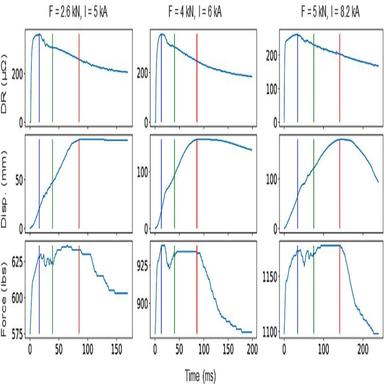
Detected phase transition points for welds under three different welding parameters. Blue line represents maximum resistance, green line is force stabilization, and red line is maximum displacement. (For interpretation of the references to color in this figure legend, the reader is referred to the web version of this article.)